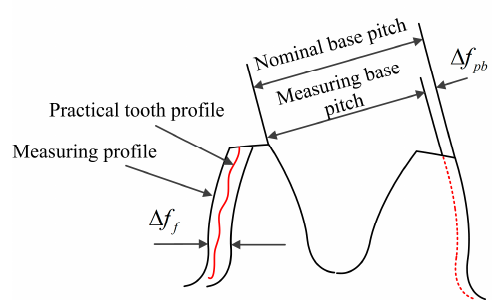
Figure 5. Tooth error and base pitch error [50] .